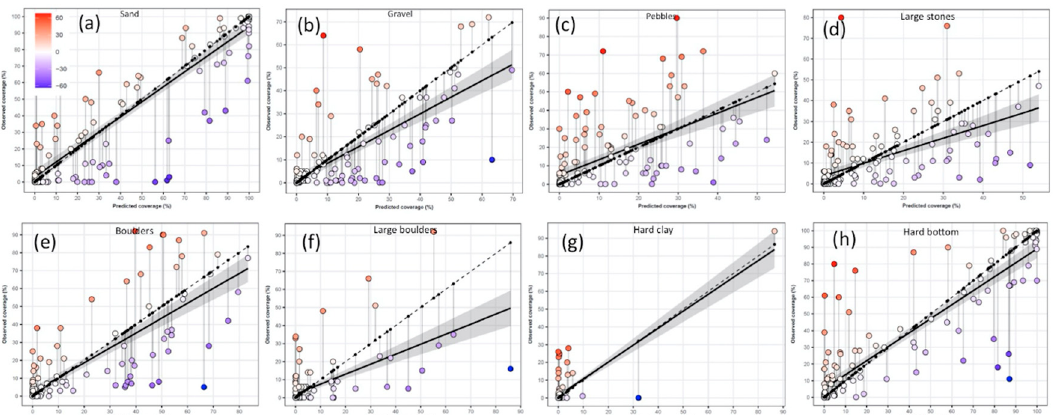
Figure 5. Relationship between observed coverage values (%) from testing data (n = 154) on the y-axis, and corresponding predicted coverage values (%) from substrate component models on the x-axis. ( a ) Sand (0.02–0.2 cm), ( b ) gravel (0.2–2 cm), ( c ) pebbles (2–6 cm), ( d ) large stones (6–20 cm), ( e ) boulders (20–60 cm), ( f ) large boulders (60 cm), ( g ) hard clay, ( h ) hard bottom. The solid black line corresponds to the linear regression and 95% confidence band (grey shade) between observed and predicted coverage. The dashed line corresponds to a theoretical 1:1 line where observed and predicted values are equal (i.e., y = x, y-intercept = 0, slope = 1), black points along this line represent the specific predicted coverage values. Point colors represent the magnitude of di ff erence between an observed value and its corresponding predicted value on the 1:1 line (black point). Table 9. Accuracy of percent coverage substrate components (individual models adjusted to sum to 100%). Distribution of the ground-truth dataset divided into HUB 3 classes are available in Table A4. Accuracy was measured (testing data, observed vs. predicted) with R 2 , root mean square error (RMSE), mean absolute error (MAE) and mean error (ME), in addition, the predicted values were grouped and evaluated with overall accuracy (OA) as classes (0–10%, 10–50%, 50–90%, 90–100%) and absence - presence ( < absence threshold, > absence threshold-100%). R 2 RMSE